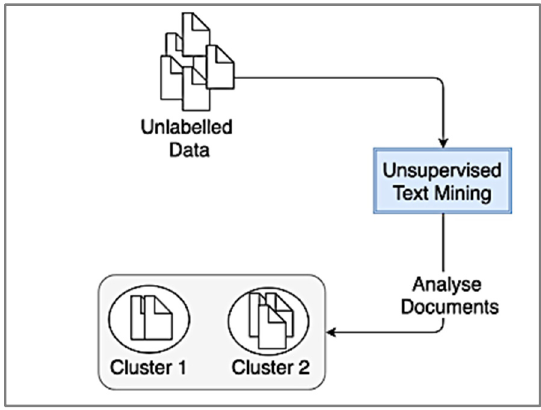
Figure 2. High-level overview of an unsupervised text-mining approach.